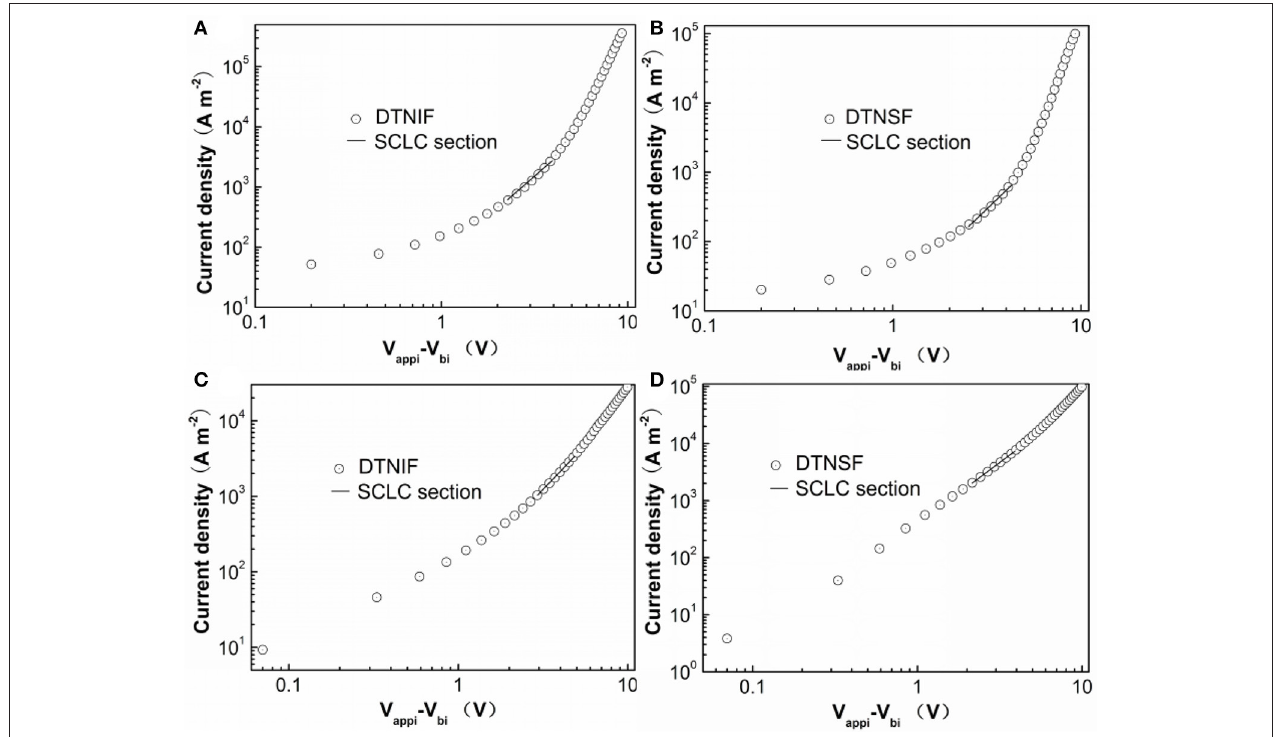
FIGURE 7 | J – V characteristic for (A,C) DTNIF and (B,D) DTNSF-based (A,B) electron-only and (C,D) hole-only devices.